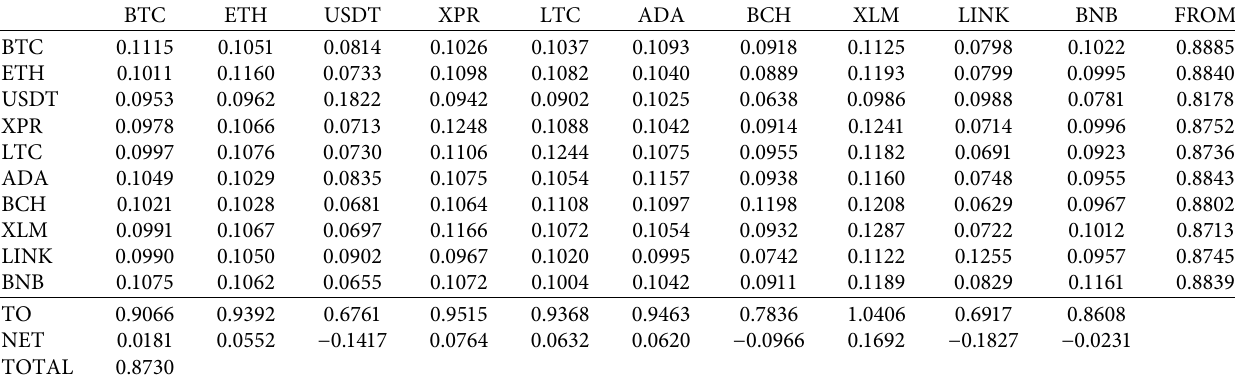
Table 5: Total, net, and pairwise spillovers among cryptocurrencies post-COVID-19 (volatility spillovers).